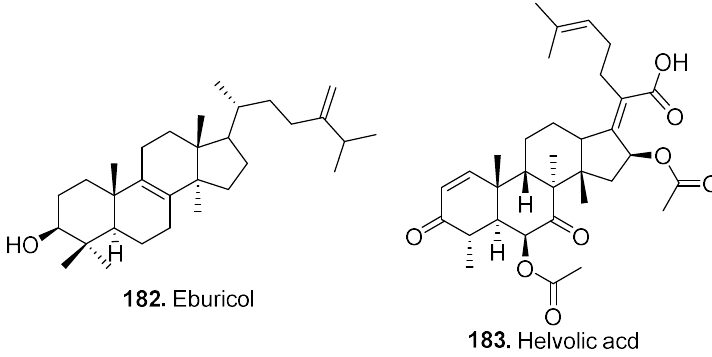
Figure 12. Triterpenoids isolated from Clonostachys fungi.